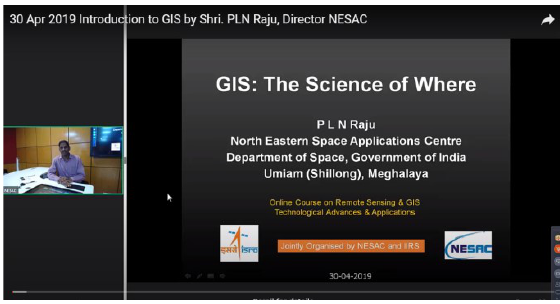
Figure 2. A demonstration of web interface as accessed by participants at IIRS Youtube Channel during a